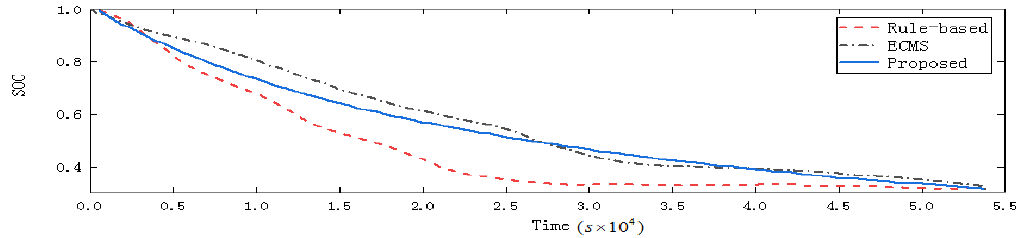
Figure 16. SOC comparison between three strategies. Table 3. Energy consumption comparison.